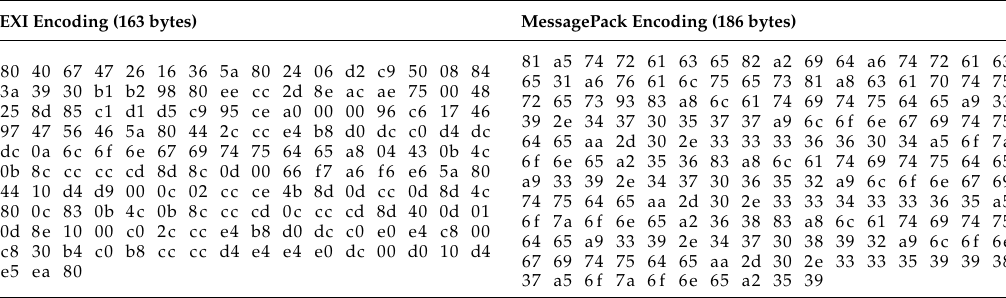
Table 2. Example of data representation using compressed (binary) encoding